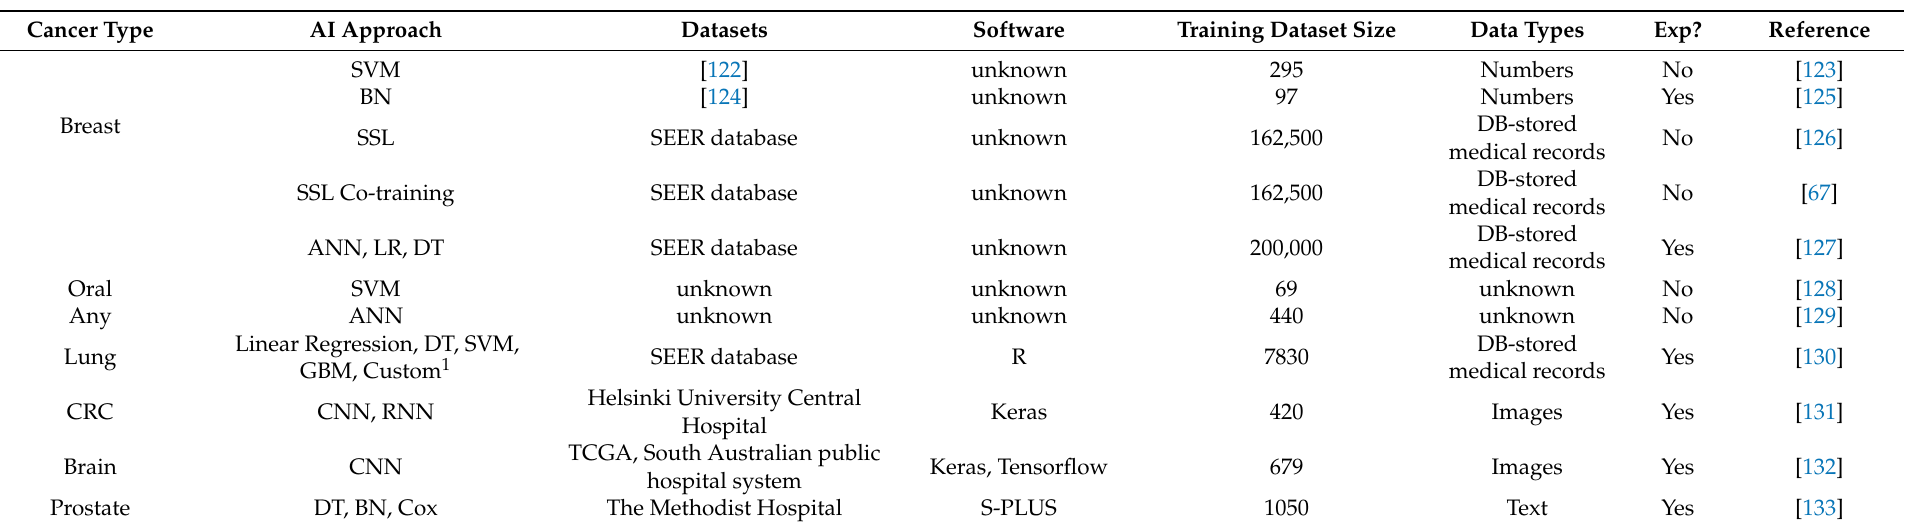
Table 6. Summary of works about ML and the likelihood of